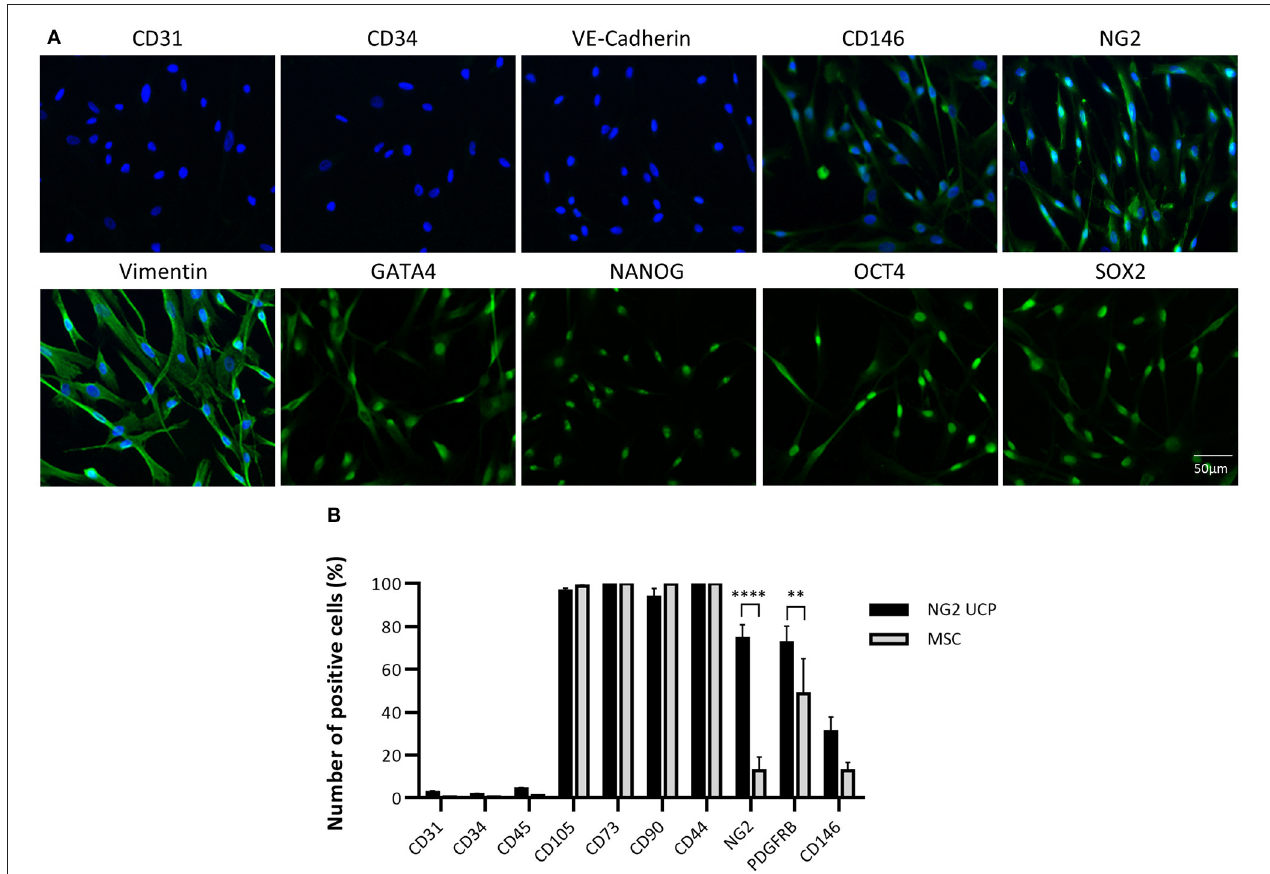
FIGURE 3 | Phenotypic characterization of NG2 UCPs. (A) Immunocytochemical staining of NG2 UCPs showing expression of CD146, NG2, vimentin, cardiac transcriptional factor GATA-binding protein 4 (GATA4), transcription factor NANOG, octamer-binding transcription factor 4 (OCT4), and sex-determining region Y-box 2 (SOX2). NG2 UCPs lack expression of endothelial factors CD31, CD34 and vascular endothelial cadherin (VE-Cadherin). (B) Summary of the expression profile obtained using flow cytometry. PDGFR- β , platelet-derived growth factor receptor beta. Data represent means ( ± S.E.M). MSCs and NG2 UCPs, n = 5 and 7 biological replicates, respectively. ** p < 0.01 and **** p <